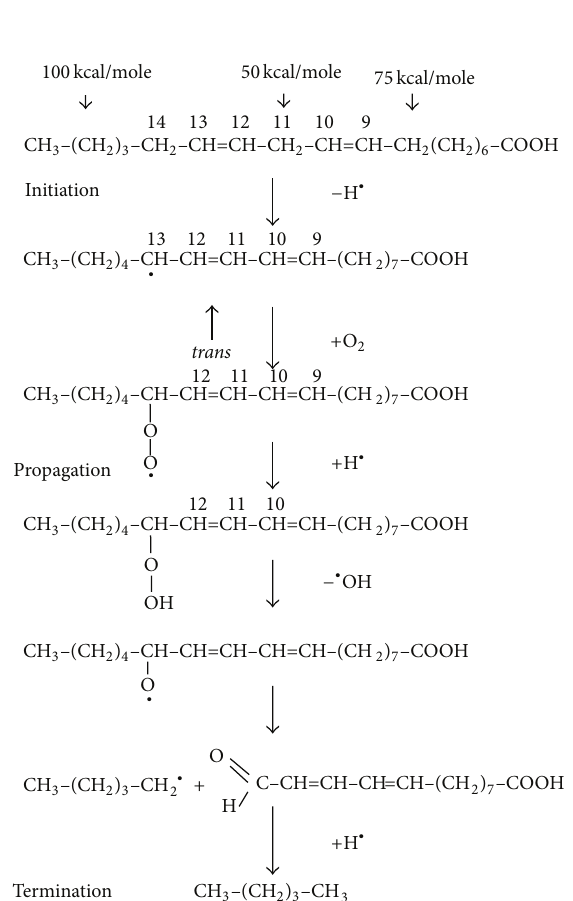
Figure 1: Structure of major pigments in arachis oil.